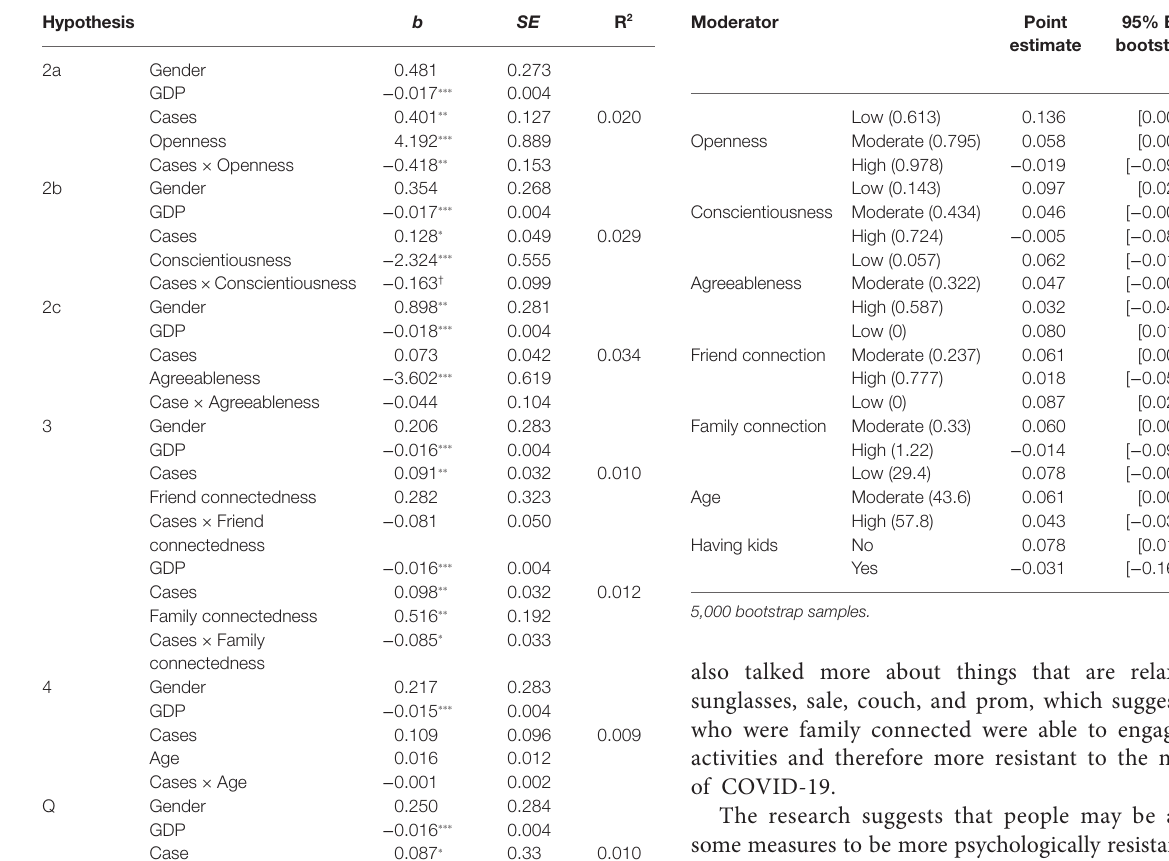
TABLE 4 | Relationship between confirmed cases on the negative affect of working adults at different levels of hypothesized moderators ( N = 2,231).